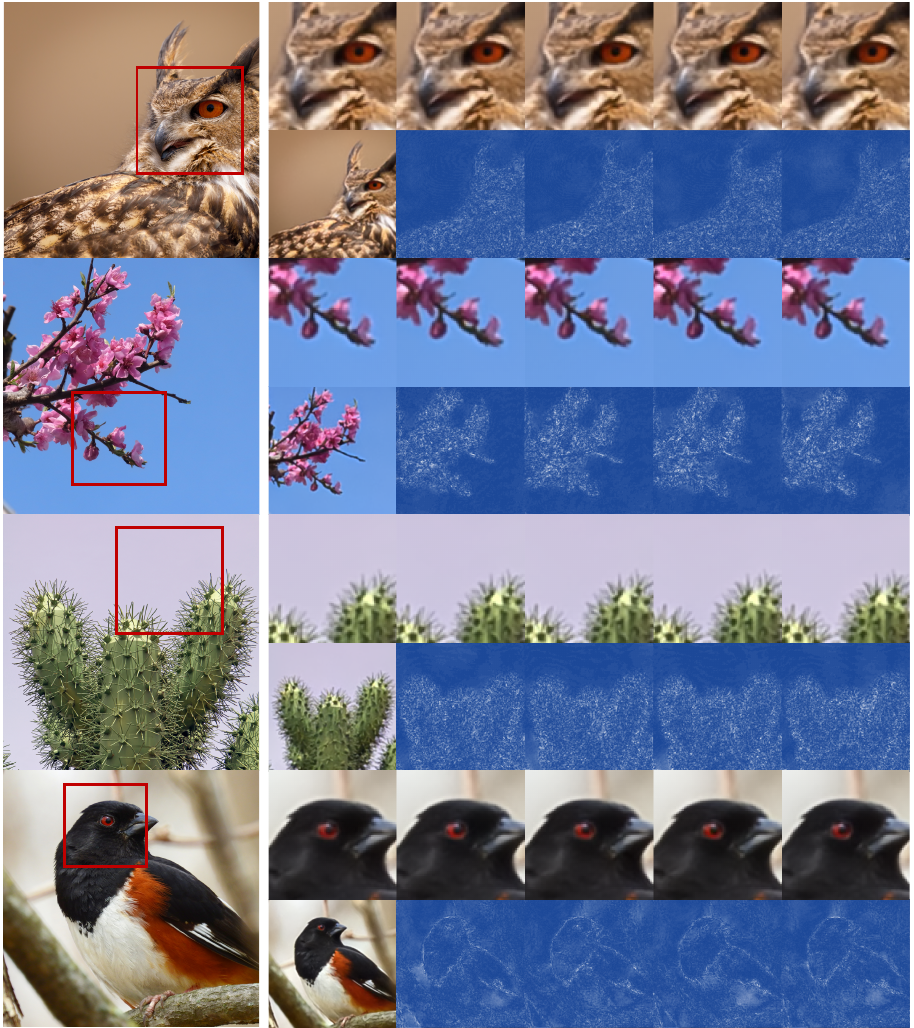
Figure 2. Random samples generated by IDFlow with × 4 down-sampling using a sampling temper- ature τ = 0.7. For each HR image in the first column, the first row presents zoomed local regions of five synthetic LR examples.The second row presents the absolute pixel-value difference maps between the first LR image and the rest of the